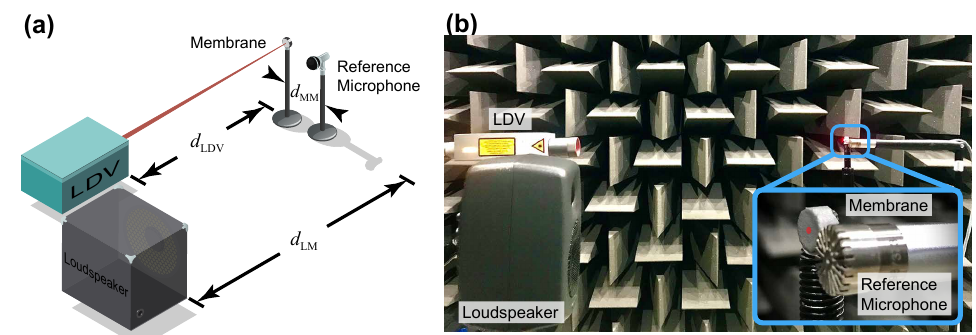
Figure 4. ( a ) System configuration. ( b ) Experimental setup.